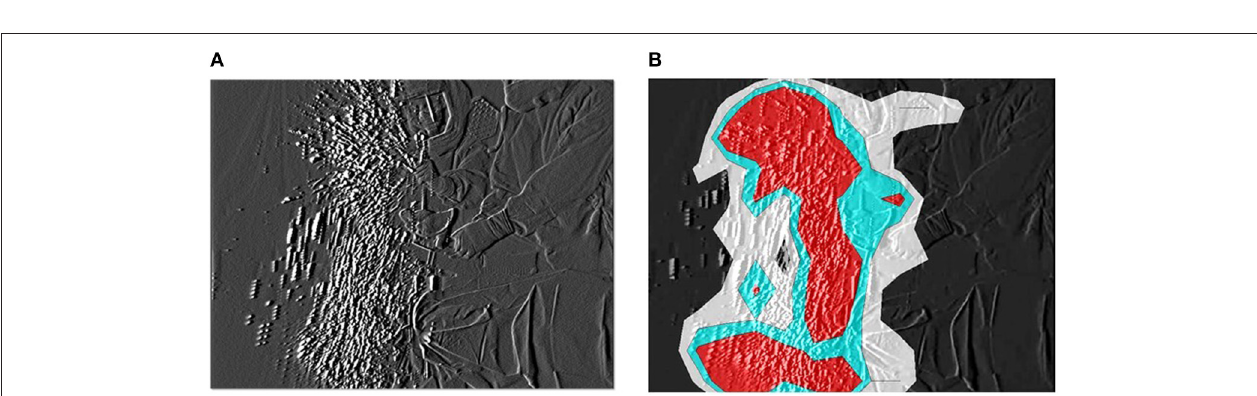
FIGURE 1 | Resecting the distal femoral condyle with the bone saw. The fine particle visualization system shows dispersal of reflective airborne particles (bright dots). (A) Many particles including bone tissue and BBF disperse in the direction of saw blade oscillation. (B) The particle density hazard map shows risk areas as ultra-high (red), high (light blue) or medium (white) density zones.